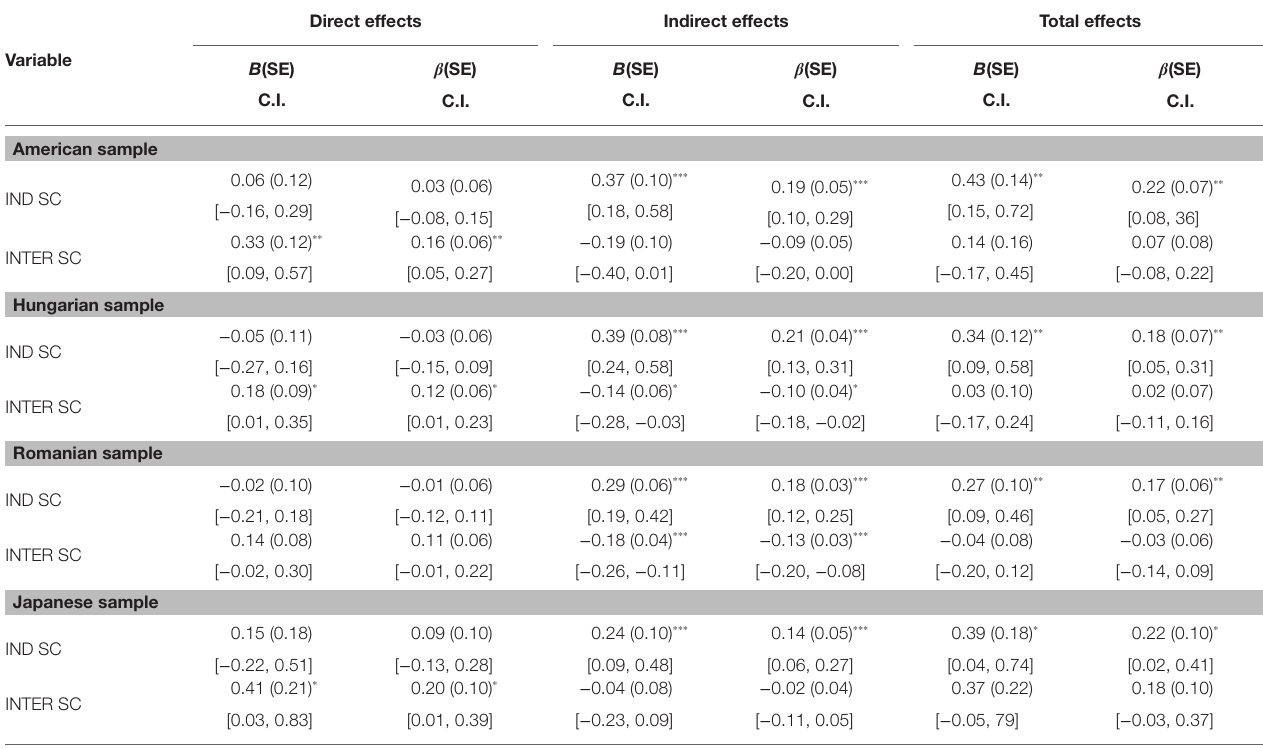
TABLE 5 | Direct, indirect, and total effects of independent and interdependent self-construals on life satisfaction in all four cultural samples in Study 1.